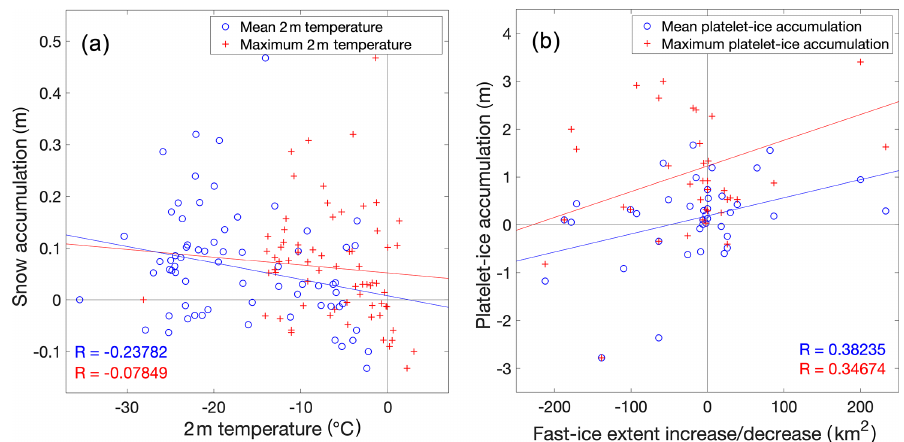
Figure 8. Scatter plot comparing (a) the average 2m air temperature (see Sect. 2.4) and the snow accumulation between two consecutive surveys, and (b) increasing (positive values) and decreasing (negative values) fast-ice extent and platelet-layer thickness between two con- secutive surveys. The analysis includes all measurements at all sampling sites throughout the study period from 2010 to 2018. Blue circles and red crosses denote the respective mean and maximum values within the time frame between the consecutive measurements. Colored solid lines in (b) show the linear regression between both parameters with the respective correlation coefficients R